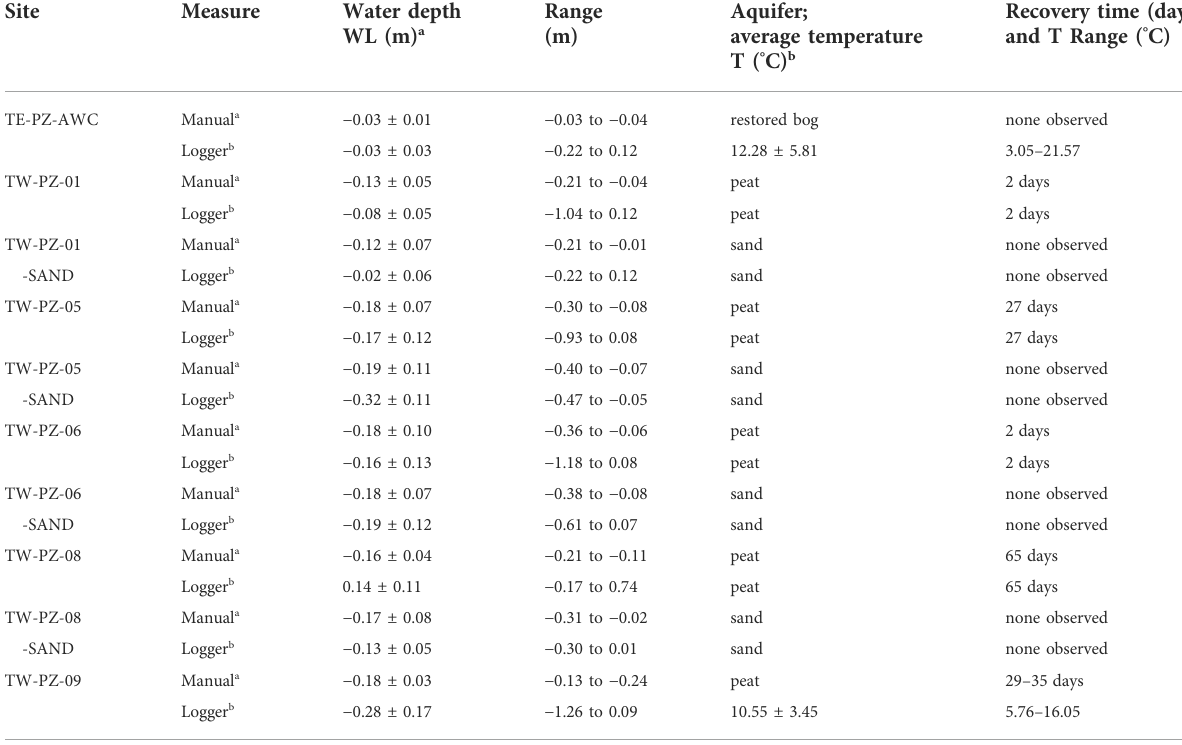
TABLE 4 Summary of pre-restoration water levels in bog